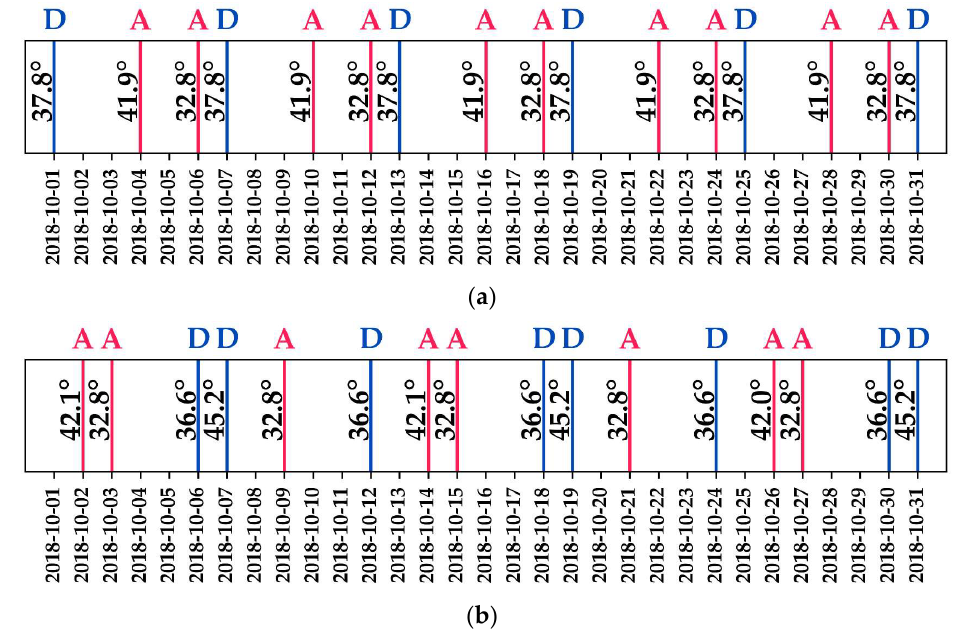
Figure 3. Repeat cycle of the Sentinel-1 synthetic aperture radar (SAR) images in ascending “A” (afternoon, red) and descending “D” (morning, blue) modes for the month of October 2018: ( a ) study site A, and ( b ) study site B. The number next to each line represents the incidence angle for each acquisition.